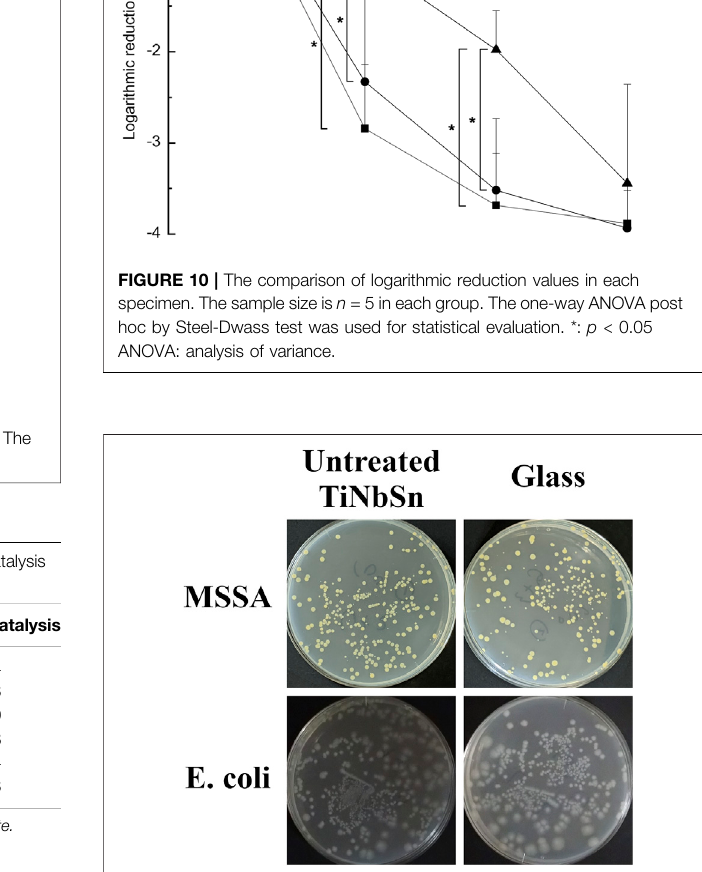
FIGUREA1| Bacterialculture tests onuntreated TiNbSn alloy andglass plate. The photographs show the results of the culture of MSSA and E. coli washout solution after antibacterial tests with untreated TiNbSn alloy and glassplateunderlow-intensityUVlightirradiation(0.21 mW/cm 2 )for8 h. Three independent experiments were conducted. Representative results are shown. E. coli: Escherichia coli, MSSA: Methicillin-resistant Staphylococcus aureus